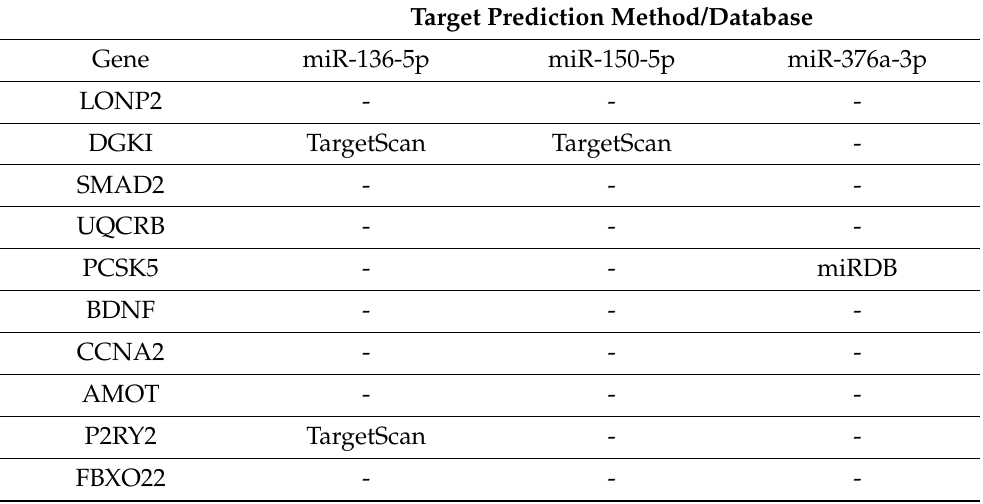
Figure 3. Expression patterns of miRNA expression fold change above 1.25 or below 0.8 after both treatments: ( a ) miR-136-5p, ( b ) miR-376a-3p, and ( c ) miR-150-5p. Table 2. Common target genes of miR-136-5p, miR-150-5p, and miR-376a-3p, and the target prediction algorithms/databases that identified them, in addition to TarPmiR (basic algorithm in miRWalk).